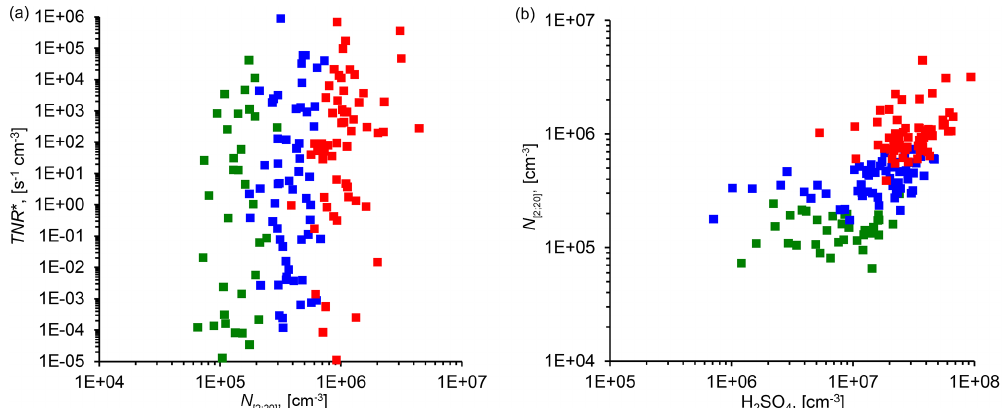
Figure E1. (a) Correlation between the ternary nucleation rate (TNR, with NH 3 = 5ppt) and ultrafine particle number concentration ( N [2;20] ). (b) Correlation between the particle number concentration N [2;20] and the calculated sulfuric acid concentration [H 2 SO 4 ] in this work. Colours refer to event class Class I (red), Class II (blue), and Class III (green).